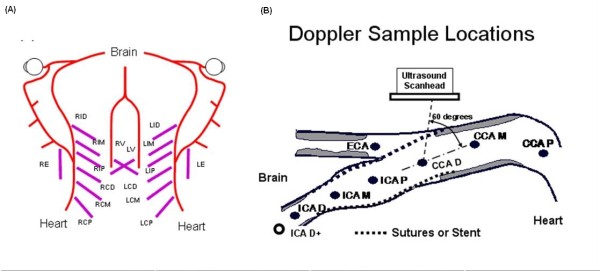
Doppler Waveform Locations. A. Map of the arterial system from the chest (bottom) to the brain (top) showing the proximal (P), middle (M) and distal (D) locations in the right (R) and left (L) common (C), and internal (I) carotid plus the external carotid (E) and vertebral (V) arteries, using short abbreviations. B. Recommended Doppler locations in the common and internal carotid arteries were separated by between 1 and 2 cm with the ICA/ECA flow divider as the key landmark, showing common abbreviations.